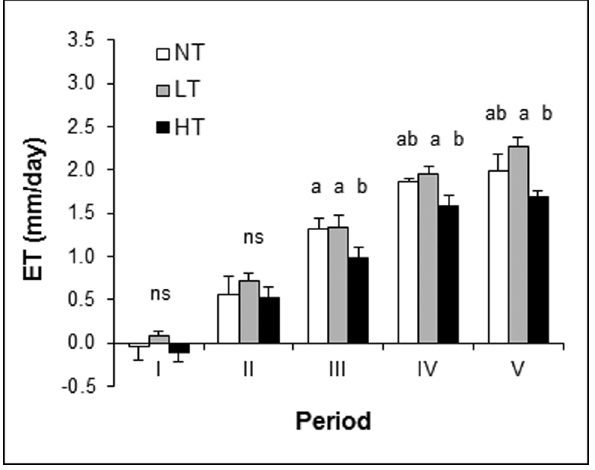
this layer (see methods). Alternatively, the step increase in N deposition from , 0.4 g m 2 yr 2 1 in Estonia to close to 4.0 g m 2